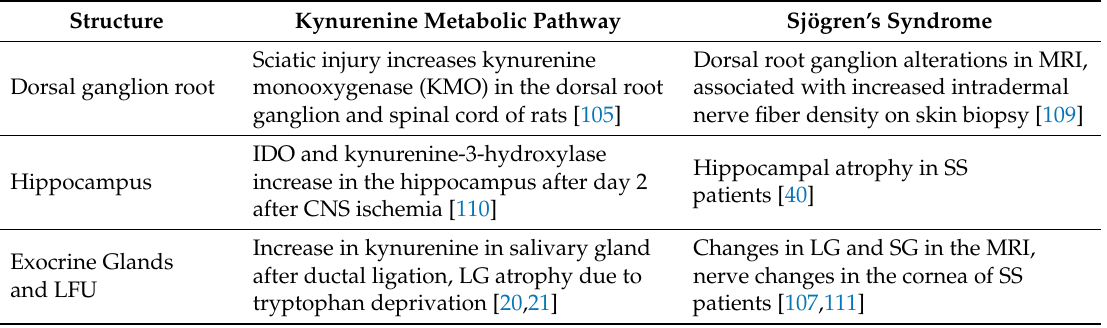
Dorsal root ganglion alterations in MRI, associated with increased intradermal nerve fiber density on skin biopsy [109] Hippocampal atrophy in SS patients [40] Changes in LG and SG in the MRI, nerve changes in the cornea of SS patients